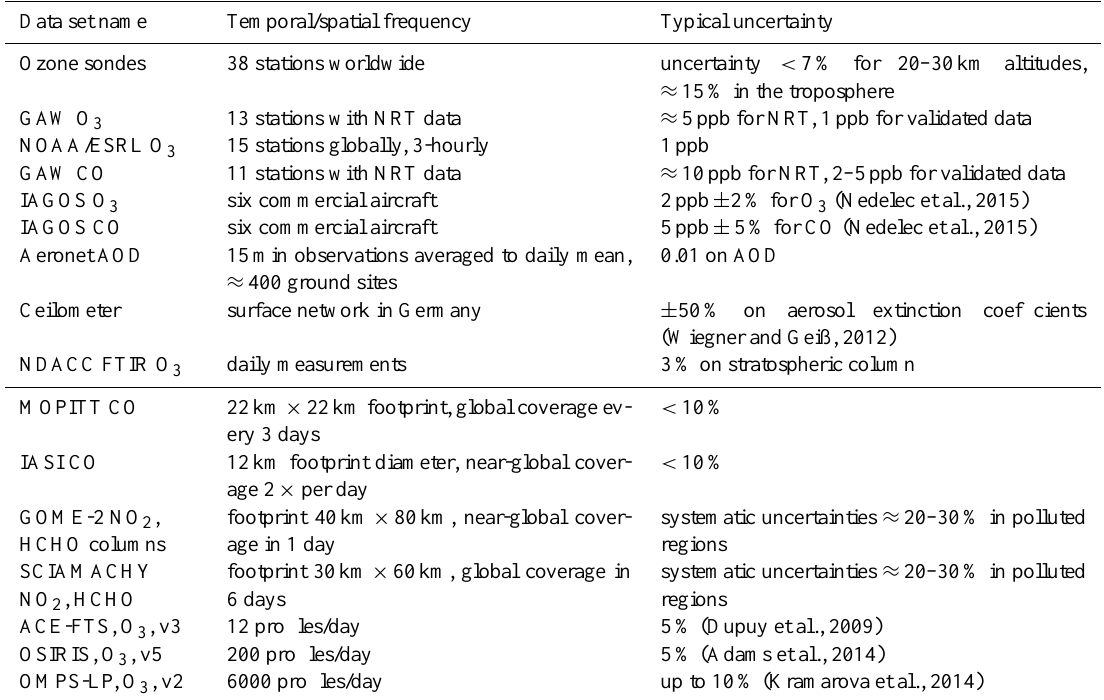
Table 2. Overview of the estimated measurement uncertainties and the temporal and spatial properties of the